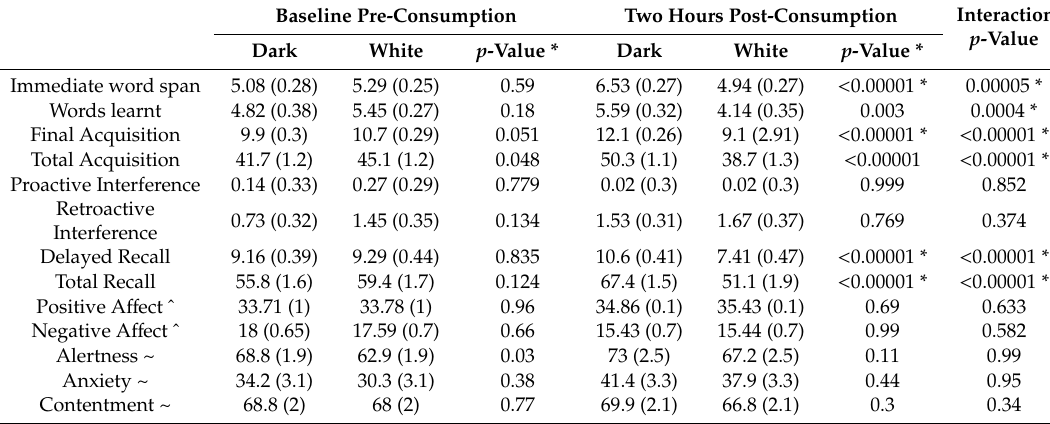
Table 2. Means and standard error (words) for all outcomes with the Treatment*Session ANOVA interaction and post hoc t -test statistics comparing dark chocolate ( n = 49) with white chocolate ( n = 49) at each time point; baseline and two hours post